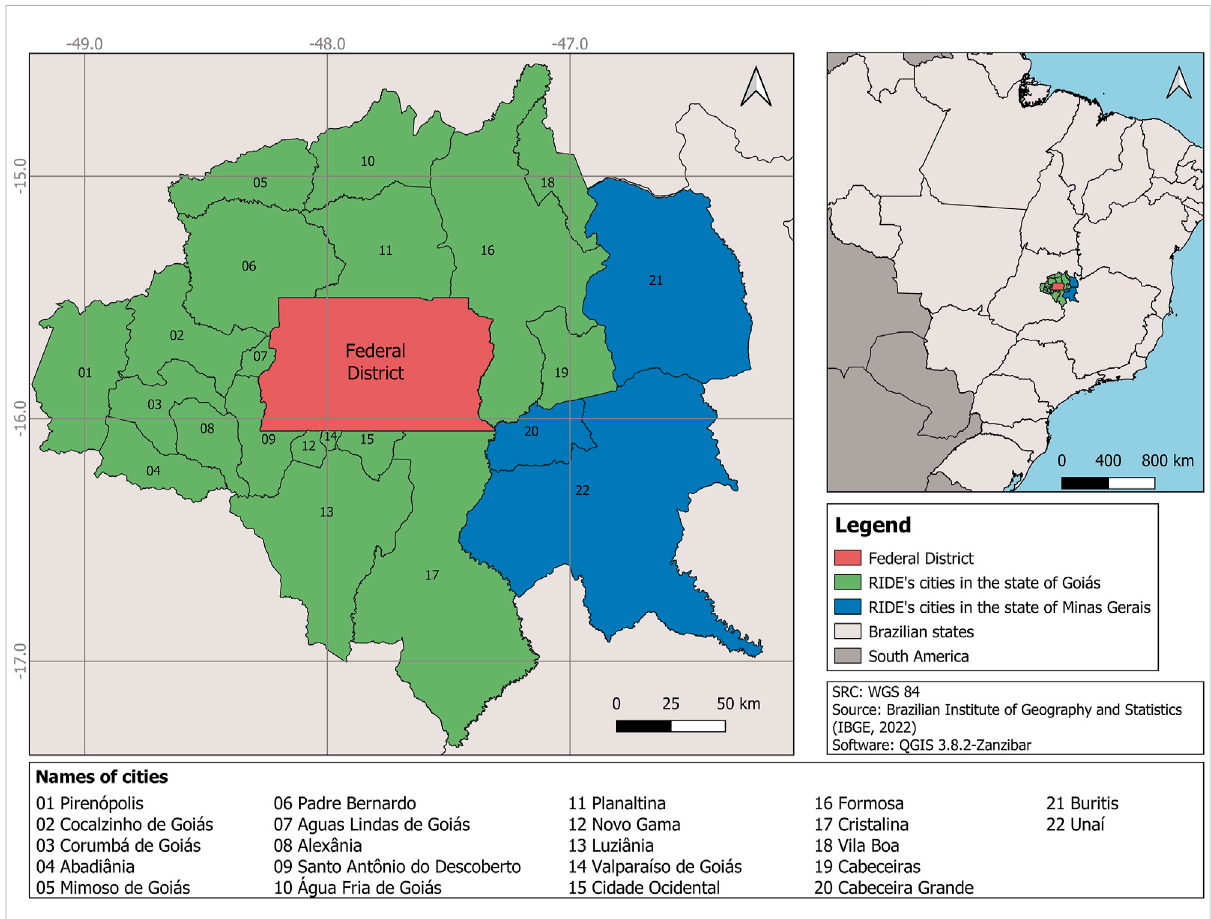
FIGURE 1 Map of the integrated development region of the federal district and surroundings